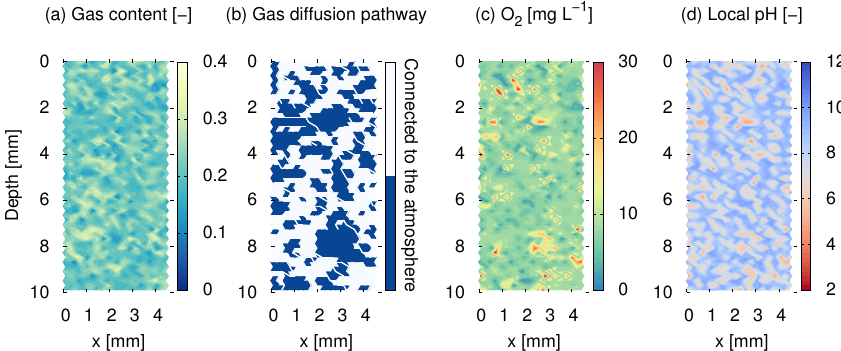
Figure 4. Aqueous-phase distribution affects diffusion pathways and geochemical conditions (no biological activity). A typical simulation result of a steady-state soil biocrust (up to 10mm of depth) when biological activities are absent at standard ambient temperature ( T = 25 ◦ C). (a) A pre-assigned soil structure determines the local gas content and configuration of water at field capacity (the aqueous phase is comple- mentary in these pore spaces). (b) The unsaturated soil permits the gas phase to penetrate over the biocrust depth along pathways (marked in blue) not blocked by the aqueous phase (marked in blue). The process is described by invasion percolation in this study. When the gas phase is connected to the atmosphere, partial pressures of gaseous compounds equilibrate to the atmospheric level as boundary conditions. Gas- and liquid-phase configurations determine the distribution of chemical species in the liquid phase. (c) The distribution of dissolved oxygen concentration and (d) localised soil porewater pH.